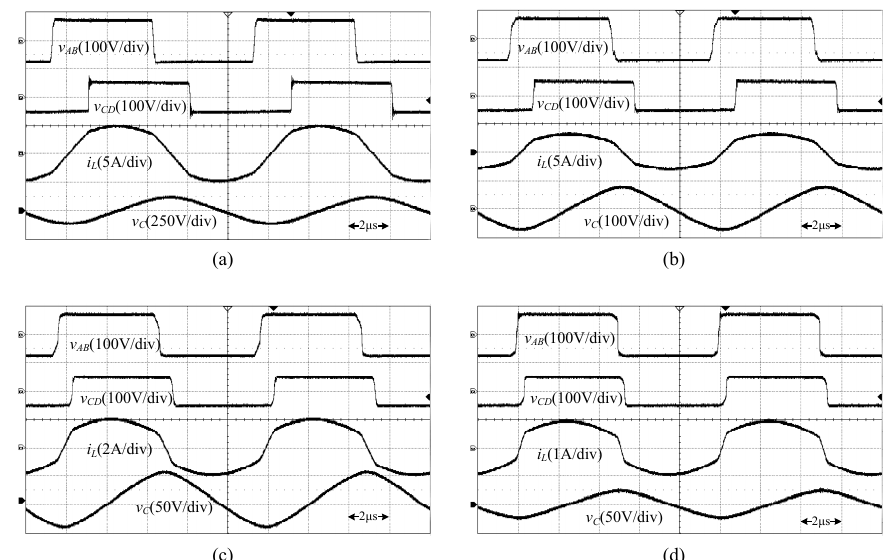
Figure 16. Experimental waveforms of different power levels when M = 1: ( a ) P o = 200 W, ( b ) P o = 150 W, ( c ) P o = 100 W, ( d ) P o = 50